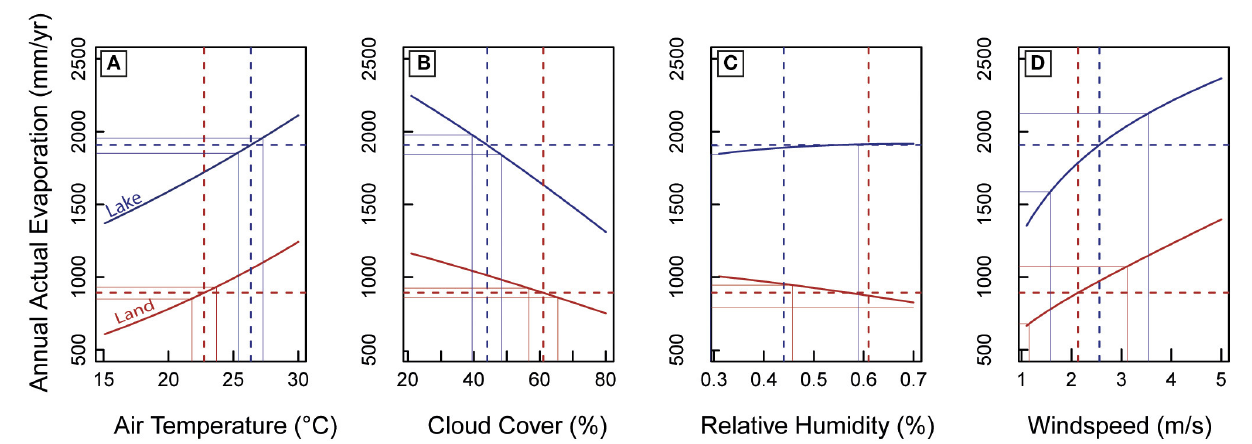
FIGURE 3 | The effects of environmental parameters on lake and land evaporation for the Chew Bahir basin: (A) air temperature, (B) cloud cover, (C) relative humidity, and (D) windspeed. Dashed lines indicate used input parameter and resulting annual actual evaporation of the LBM. Solid thin lines indicate maximum/minimum errors with resulting maxima/minima of the annual actual